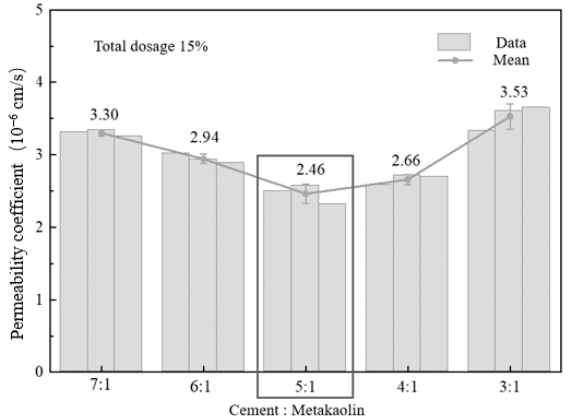
Figure 11. Permeability coefficients of MKCG with different cement to metakaolin ratios.